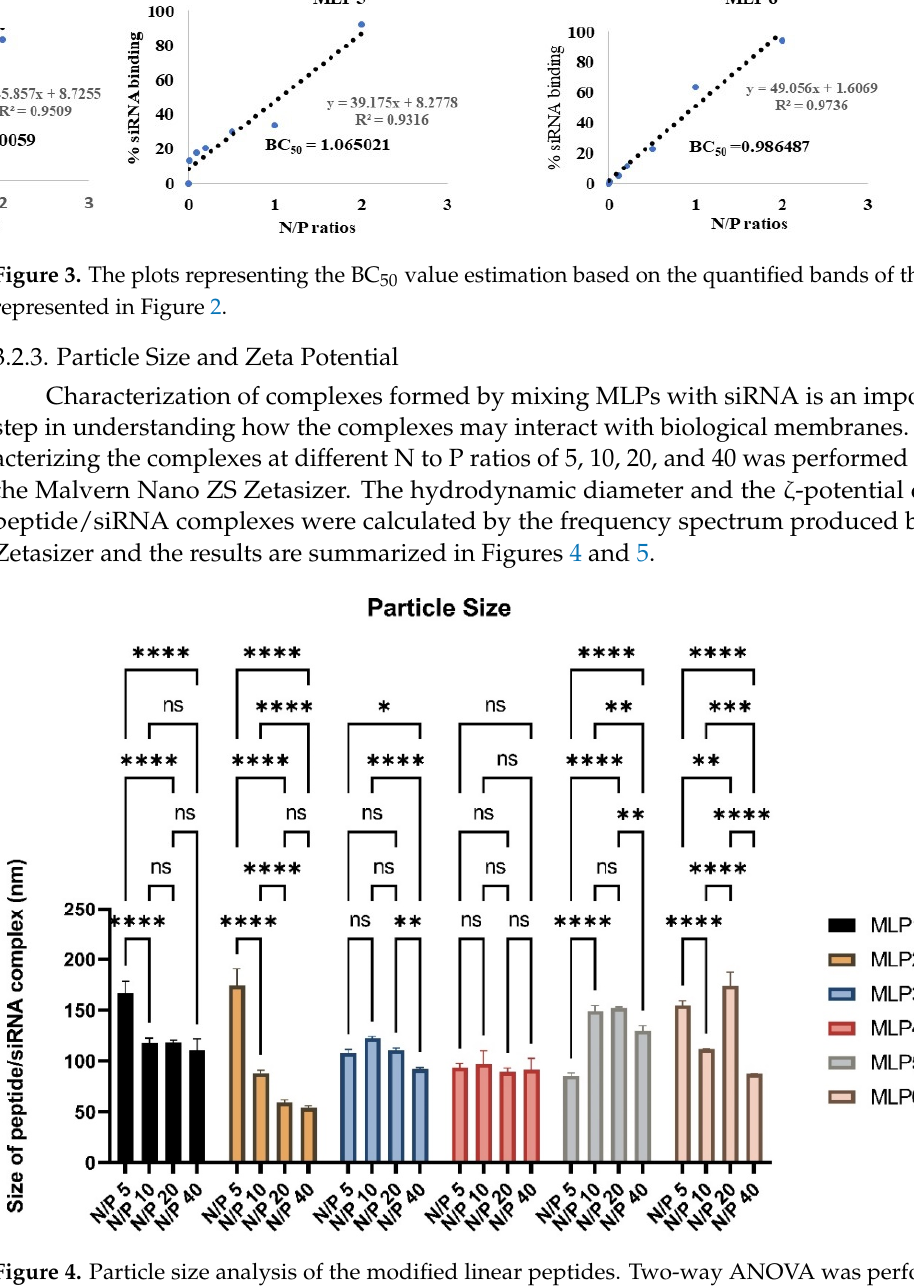
Figure 5. Zeta potential analysis of the modified linear peptides. Two ‐ way ANOVA was performed using Tukey’s multiple comparisons test to determine the effect of changing the N/P ratio on the